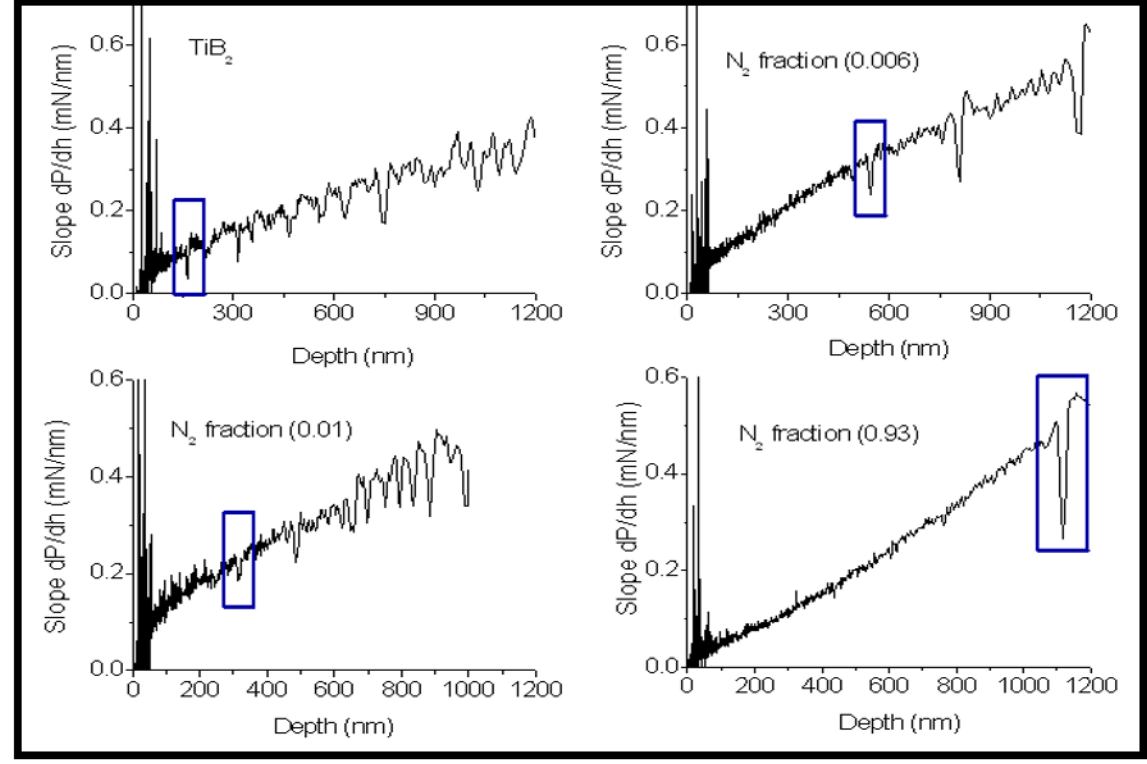
Figure 19: Slope of the loading curve vs. depth for Ti-B-N films at different N fraction in the film [265]